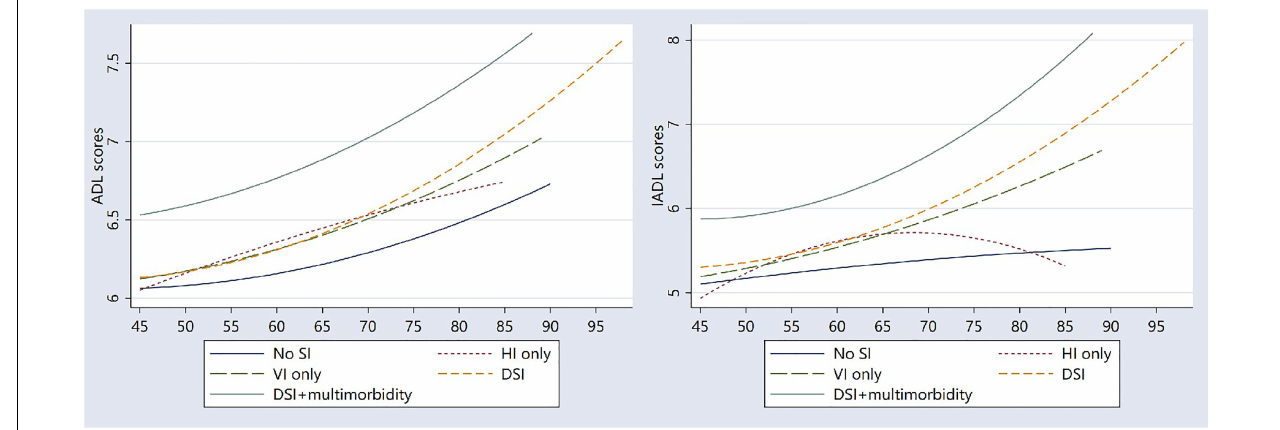
FIGURE 1 | Trajectories of ADL and IADL scores by the presence of sensory impairment and multimorbidity.